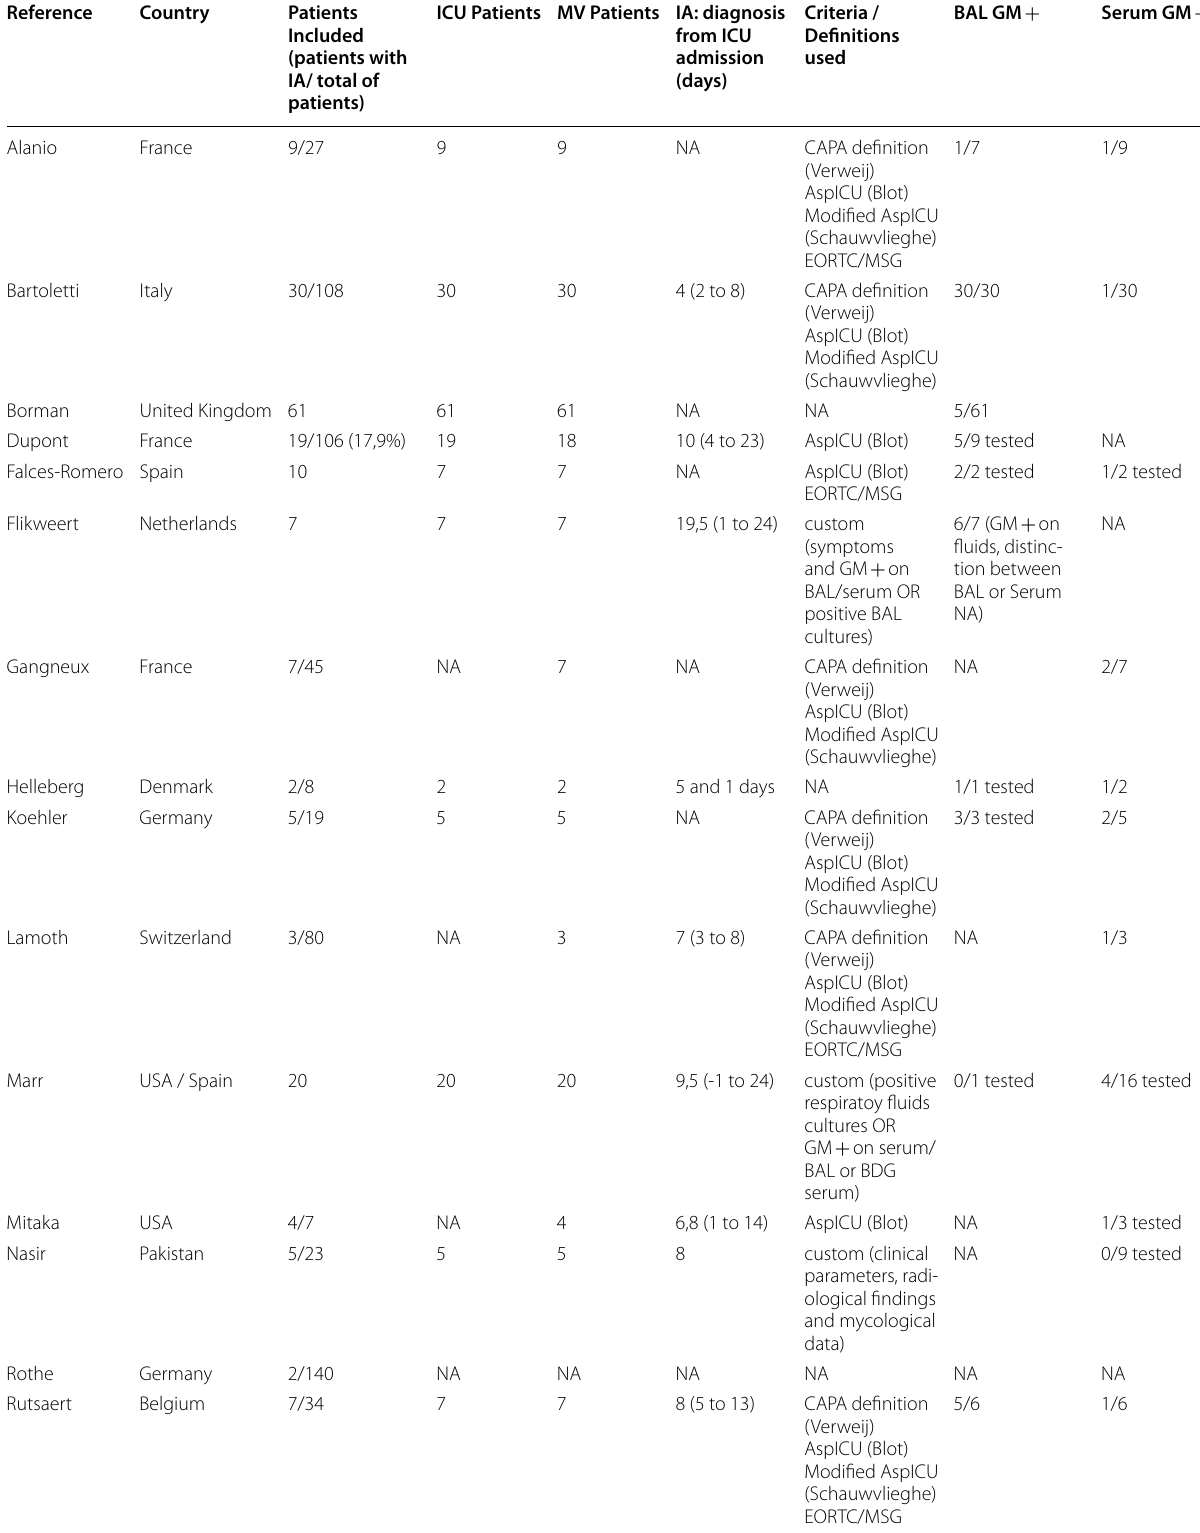
Table 1 Summary of studies that reported pulmonary aspergillosis among patients with COVID-19 Reference